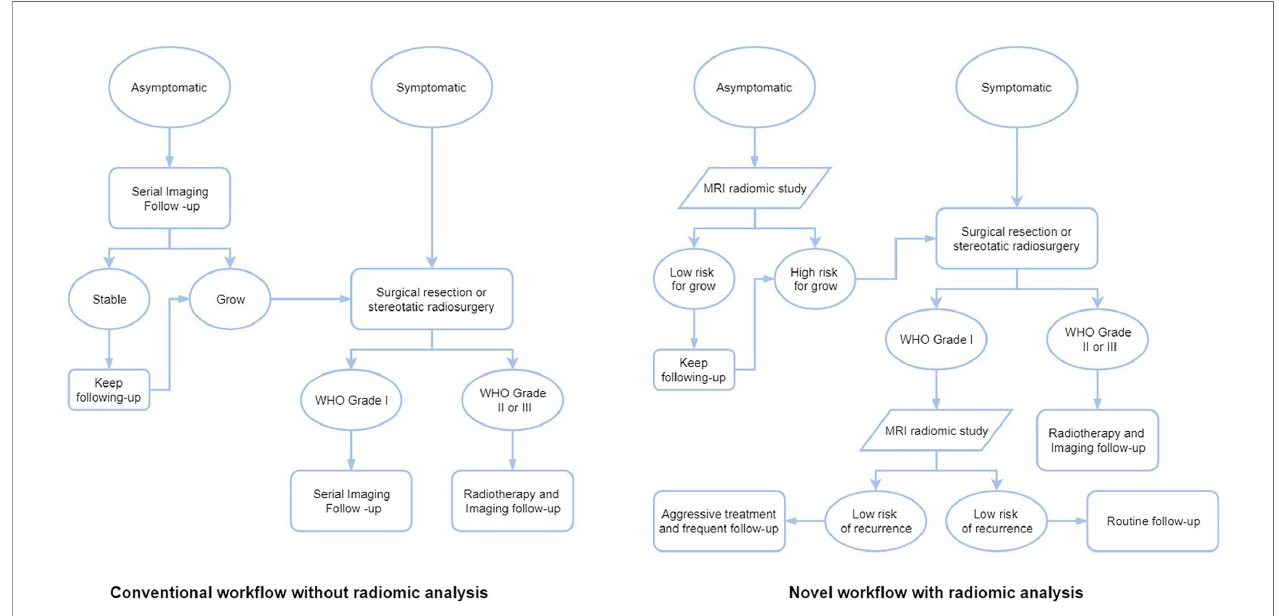
FIGURE 2 | The work fl ows of different treatment strategies of meningiomas without or with radiomic analysis.